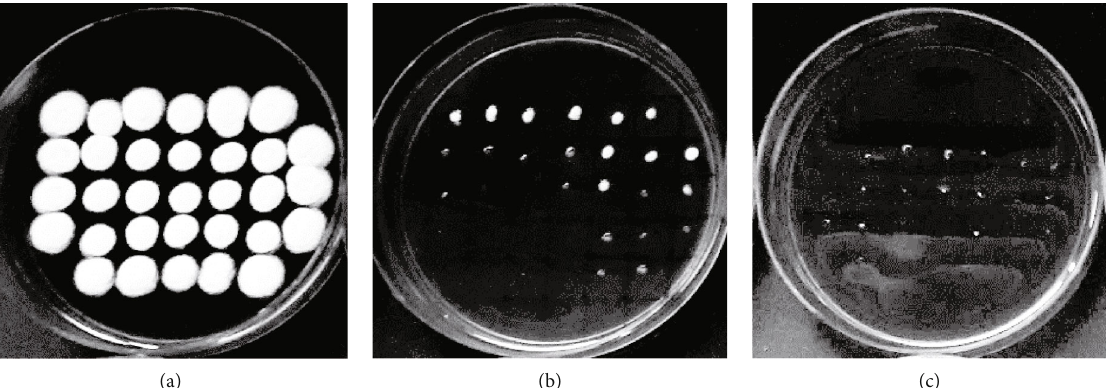
Figure 2: Growth of A. fl avus on plates exposed to crude water extract of fermented P. edule seed, after three days incubation at 28 ° C: (a) negative control (100% DMSO); (b) 3.12mg/mL; (c) 25 mg/mL. Table 3: Antifungal activity of extracts and fractionated water extract of P. edule seed against A. fl avus as determined by agar dilution. Number of detected mold spot at di ff erent concentrations Seed Extraction solvent 25mg/mL